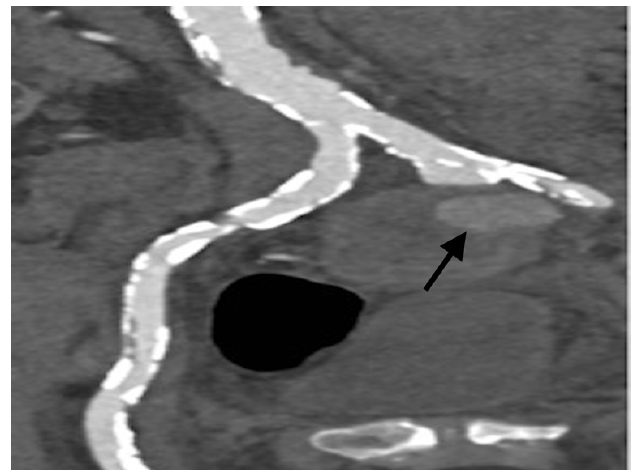
Figure 1. Coronal CTA with contrast demonstrating a PSA (black arrow) arising from the left internal iliac artery.